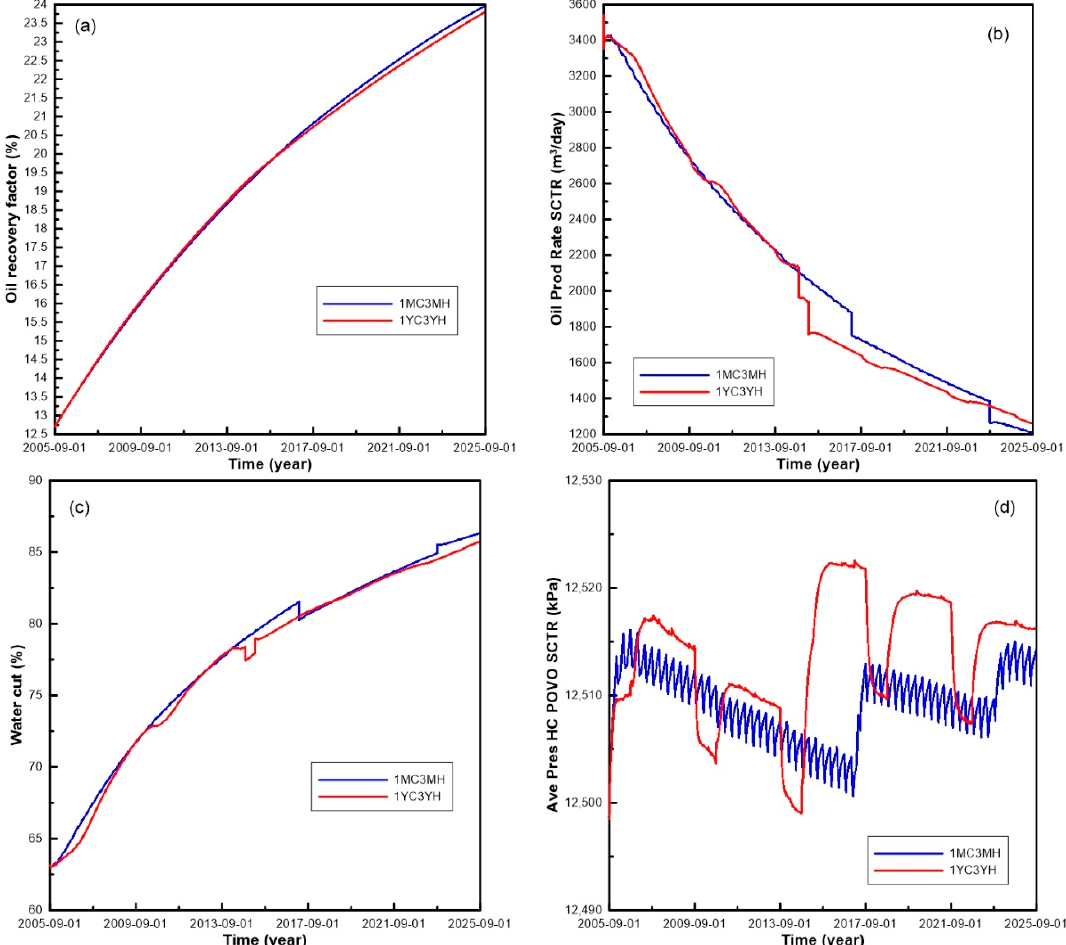
Figure 10. Simulated result curves of oil recovery factor ( a ), oil production rate ( b ), water cut ( c ) and average reservoir pressure ( d ) of during the CO 2 flooding with a WAG ratio of 1:3.